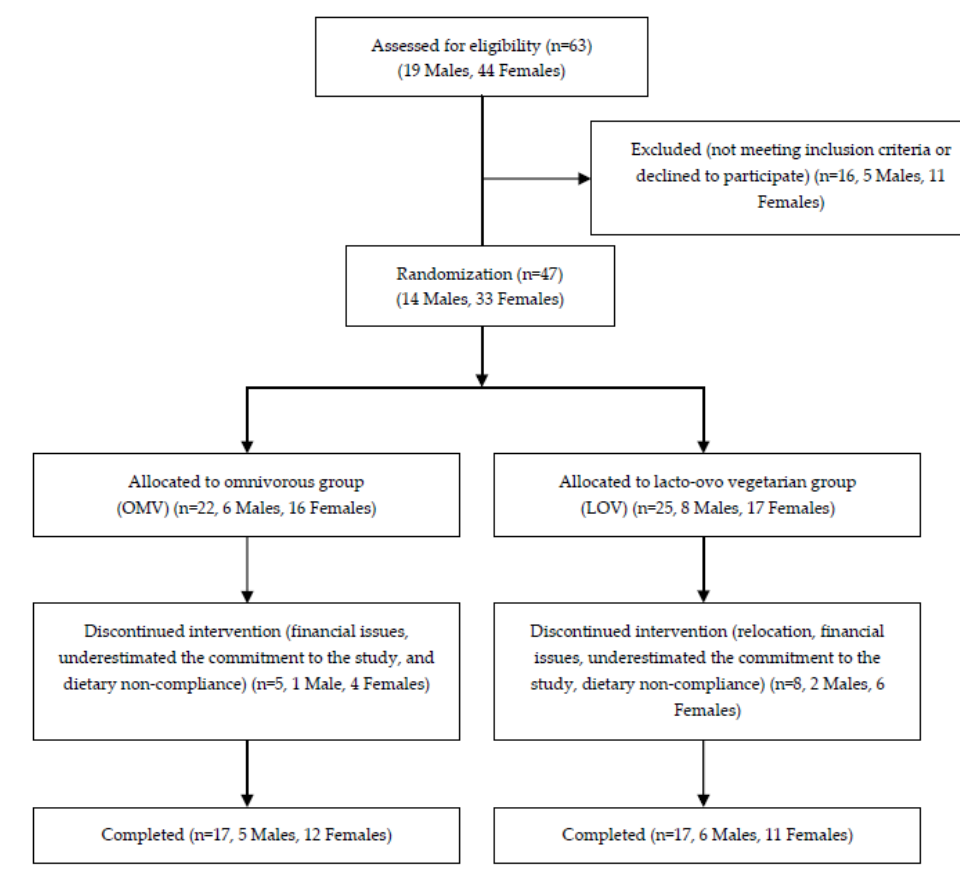
Figure 1. Study recruitment flow diagram.